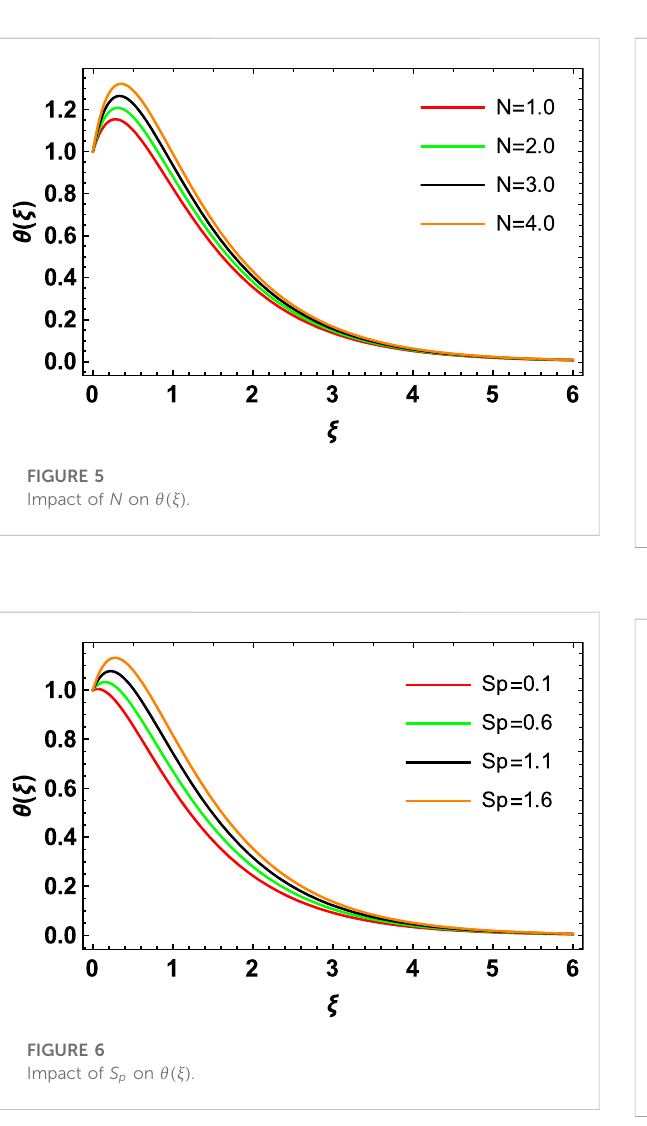
FIGURE 6 Impact of S p on θ ( ξ ) .